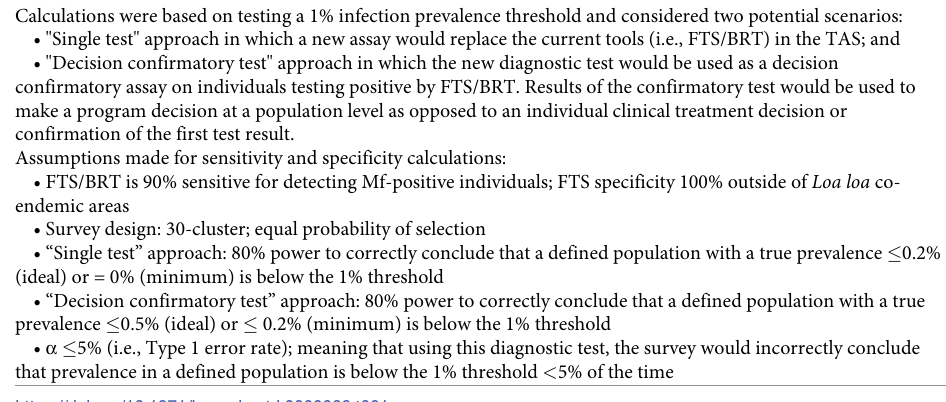
Table 1. Parameters and assumptions for use case 1: stopping IDA.